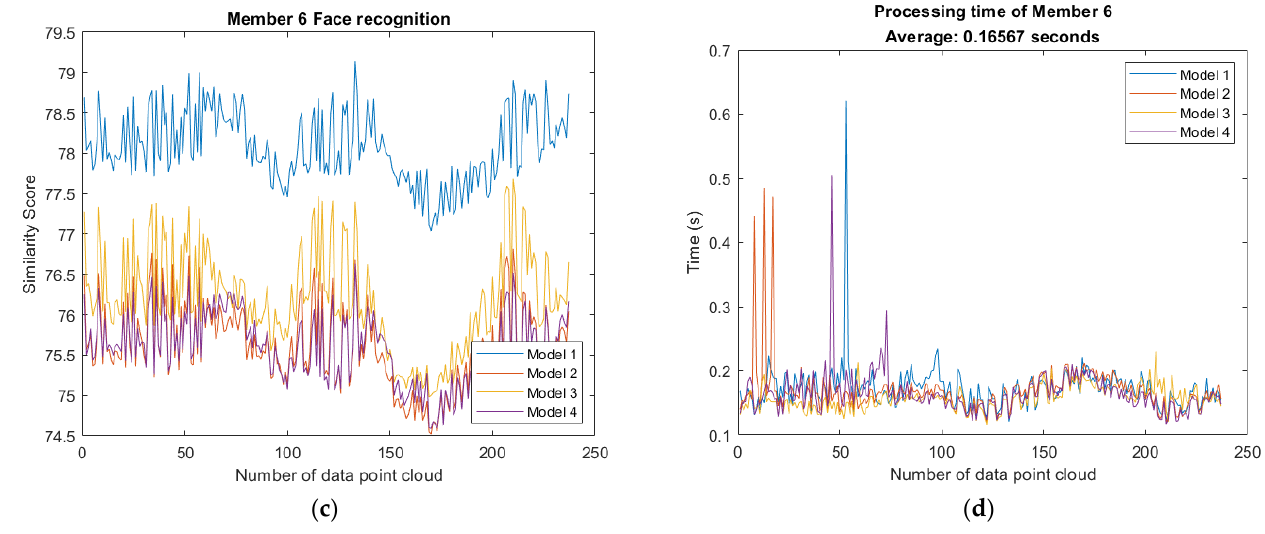
Figure 25. Result of 3D face recognition: ( a ) none of Model is recognized as Member 5; ( b ) computation time of each frame with Member 5; ( c ) none of Model is recognized as Member 6; ( d ) computation time of each frame with Member 6.